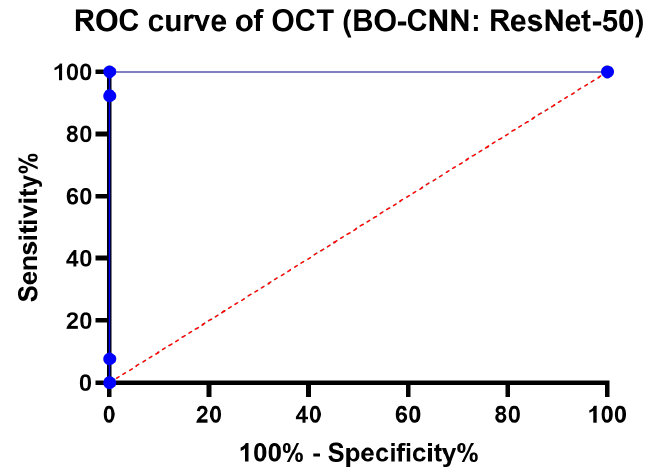
Figure 20. ROC curve of the proposed BO-CNN model vs. ResNet-50 model for the OCT dataset.